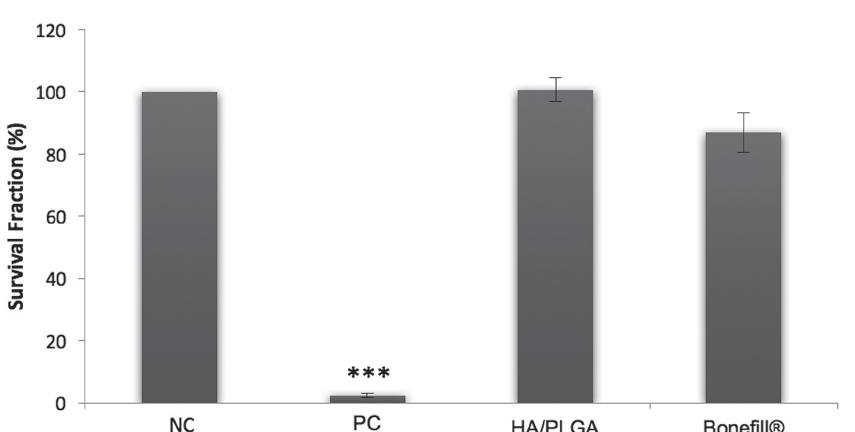
FIGURE 2 - Clonogenic survival assay in CHO-K1. Cells treated with 100% concentration HA/PLGA and Bonefill ® eluates. NC: negative control; PC: positive control. NC represents 100% survival fraction. Columns = mean of survival fraction (%); bars = Standard error. *** = p<0.0001 compared to NC; Dunnett’s